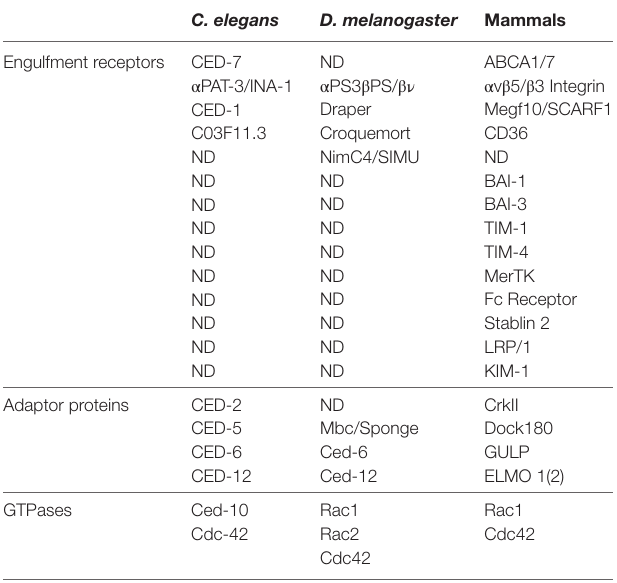
TAble 1 | Engulfment machinery in professional and non-professional phagocytes in C. elegans , D. melanogaster , and